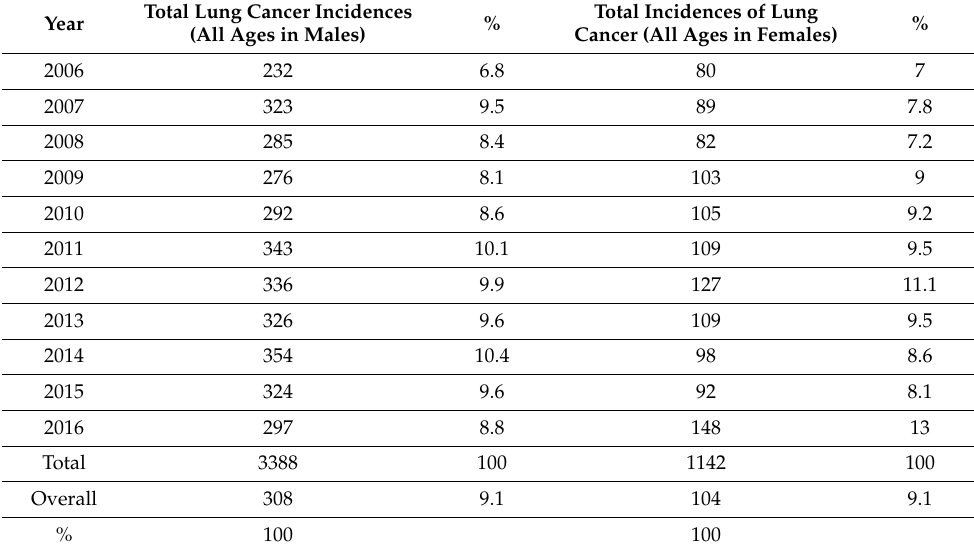
Table 1. Number and percentage of lung cancer in males and females during 2006 to 2016. Total Lung Cancer Incidences Year (All Ages in Males)